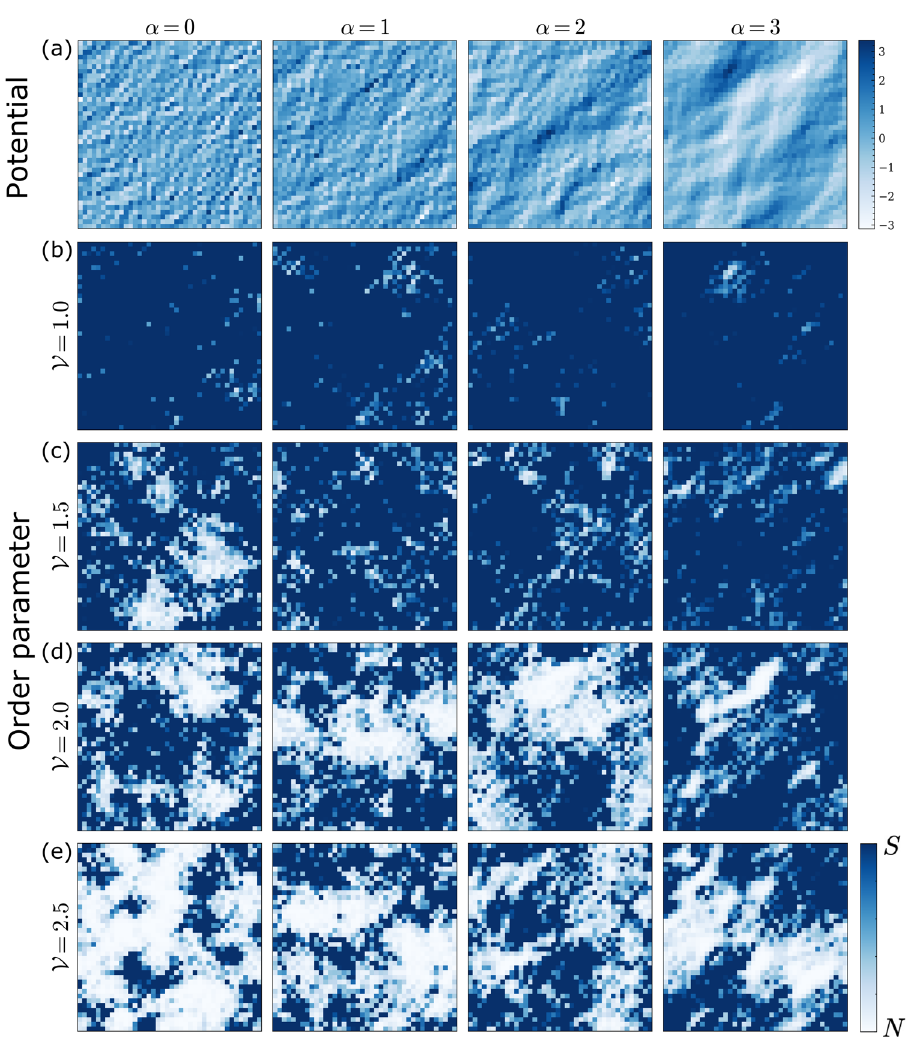
Fig. 1 Spatial pro fi les of disorder potential and order parameter. Color density plot of the spatial pro fi le of the random potential V i (row a) and of the order parameter Δ i (rows (b – e)), calculated assuming the disorder strength of V ¼ 1 : 0 ; 1 : 5 ; 2 : 0 ; 2 : 5 and the disorder correlation degree α = 0, 1, 2, 3 (panel columns). Blue and white colors denote, respectively, superconducting S and normal N domains. Each panel has its own scaling chosen for a better contrast and visibility of the regions with weak superconductivity: dark blue corresponds to the gap value Δ i > 0 : 1 Δ i , where Δ i is the average gap value.